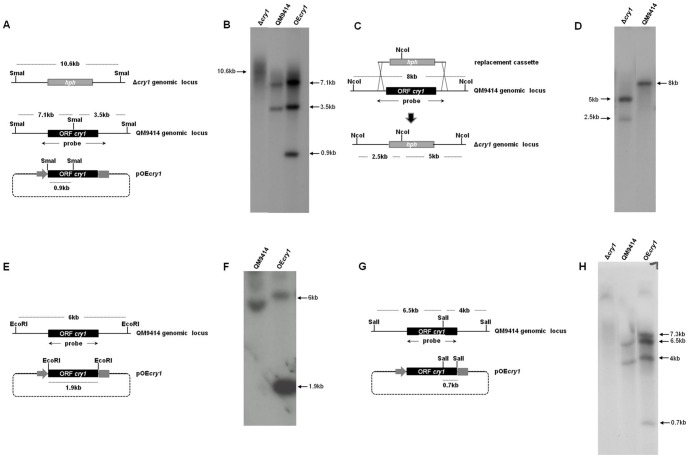
Molecular analysis of cry1 mutant and overexpressing strains.Ten micrograms of genomic DNA were digested, separated on 1% agarose gel and hybridized with the probe indicated in the scheme. The position for each restriction enzyme and the sizes of the DNA fragments generated as indicated in each diagram. A) Schematic representation of Δcry1 genomic locus, parental genomic locus cry1 and pOEcry1, digested with SmaI enzyme. B) Southern blot analysis of the parental strain (QM9414), overexpressing (OEcry1) and cry1 mutant (Δcry1). C) Schematic representation of replacement cry1::hph, digested with NcoI enzyme. D) Southern blot analysis of the parental strain (QM9414) and cry1 mutant (Δcry1). E) Schematic representation of parental genomic locus of cry1 and the pOEcry1, digested with EcoRI enzyme. F) Southern blot analysis of the parental strain (QM9414) and overexpressing (OEcry1) strains. G) Schematic representation of pOEcry1 and the parental genomic locus of cry1, digested with SalI enzyme. H) Southern blot analysis of the parental strain (QM9414), overexpressing (OEcry1) and cry1 mutant (Δcry1) strains.